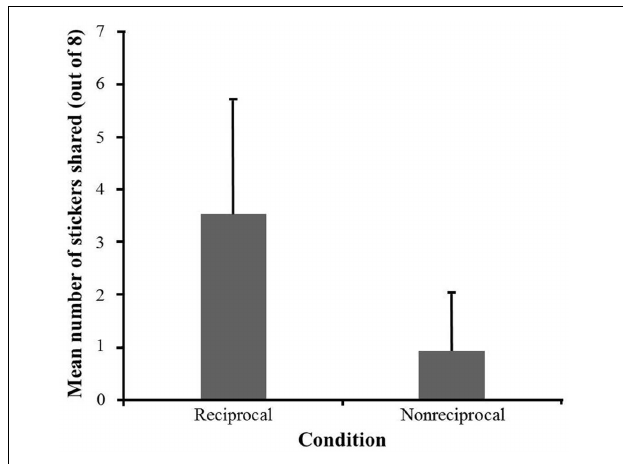
FIGURE 3 | The mean number (and standard deviation) of stickers shared in the two conditions in Experiment 1.